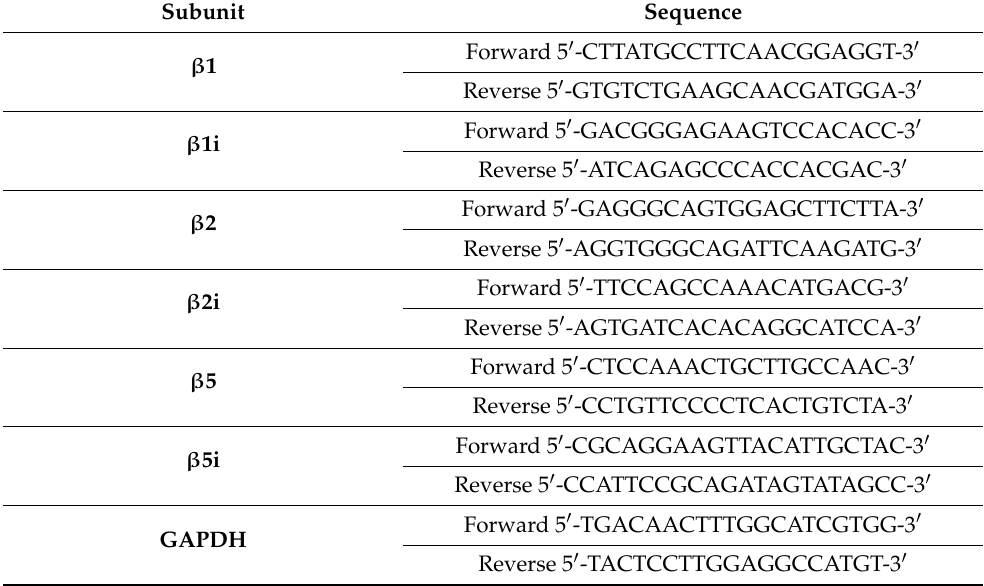
Table 1. Sequences of the primer pairs used for the real time PCR experiments. Subunit Sequence β